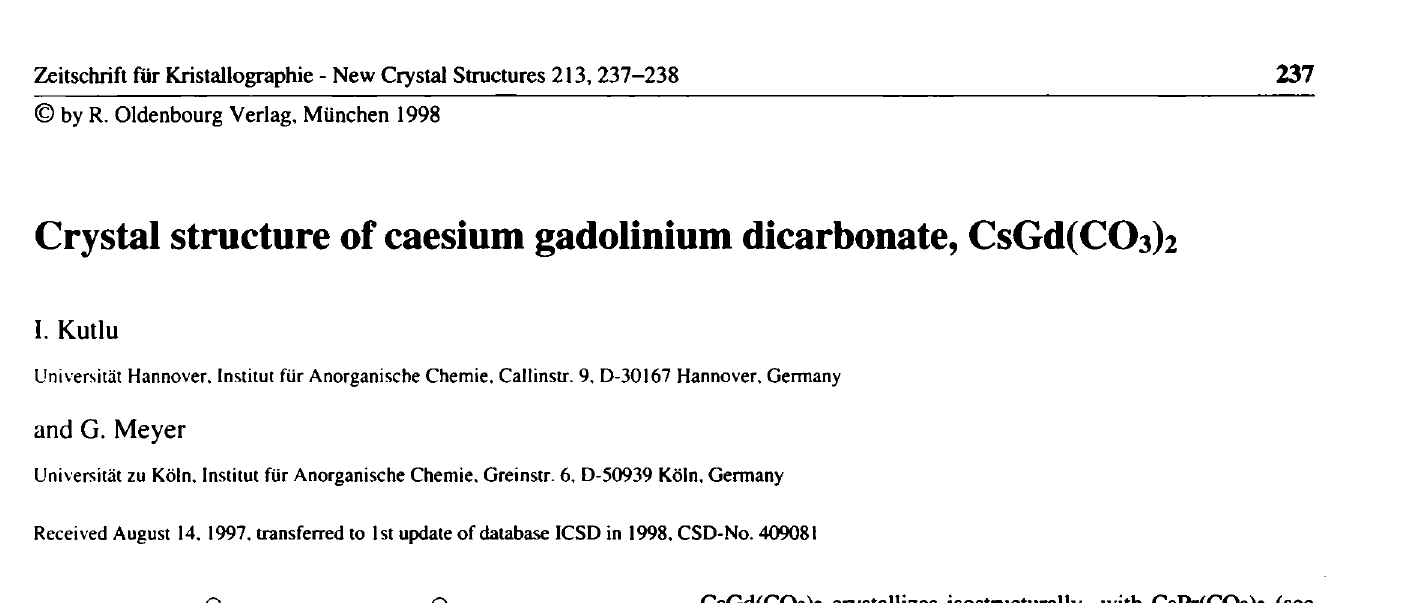
CsGd(C03 )2 crystallizes isostructurally with CsPr(C03 )2 (see ref. 2) in an ordered derivative structure of the mineral aragonite (СаСОз). The Cs-O and Gd-O polyhedra are irregular. Coordi- nation numbers, distance ranges and mean distances (in pm) are as follows: Csl: 12 / 295.4(6) - 366.6(6) / 326.4(6); Cs2: 11 / 296.(X6) - 351.4(6) / 322.9(6); Gdl: 9 / 234.2(6) - 259.6(6) / 247.8(6); Gd2: 8/233.3(6)-250.1(6)/241.3(6).